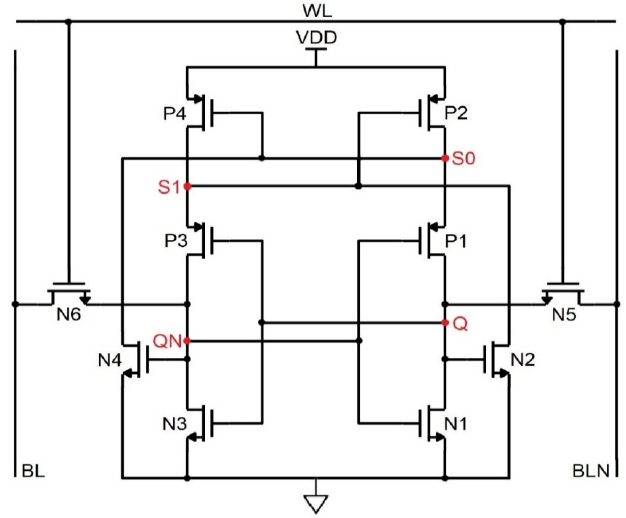
Figure 5. Schematic of the PMOS stacked 10T SRAM (PS-10T).